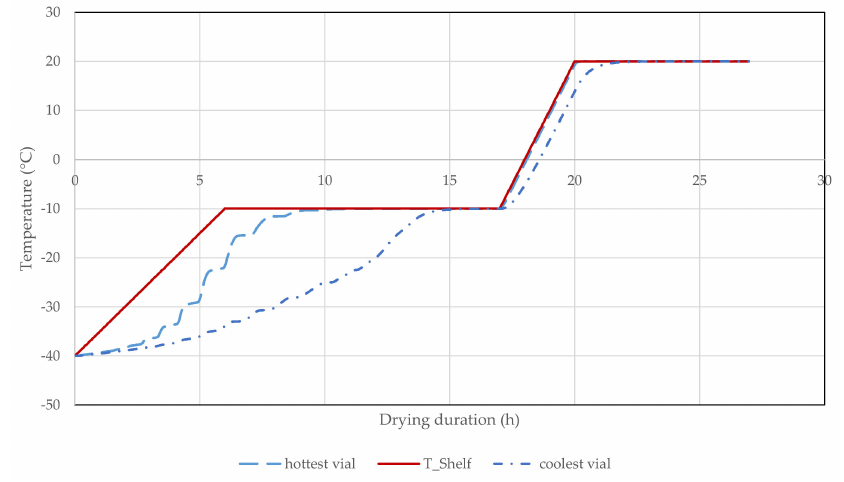
Figure 20. Shelf and product temperature